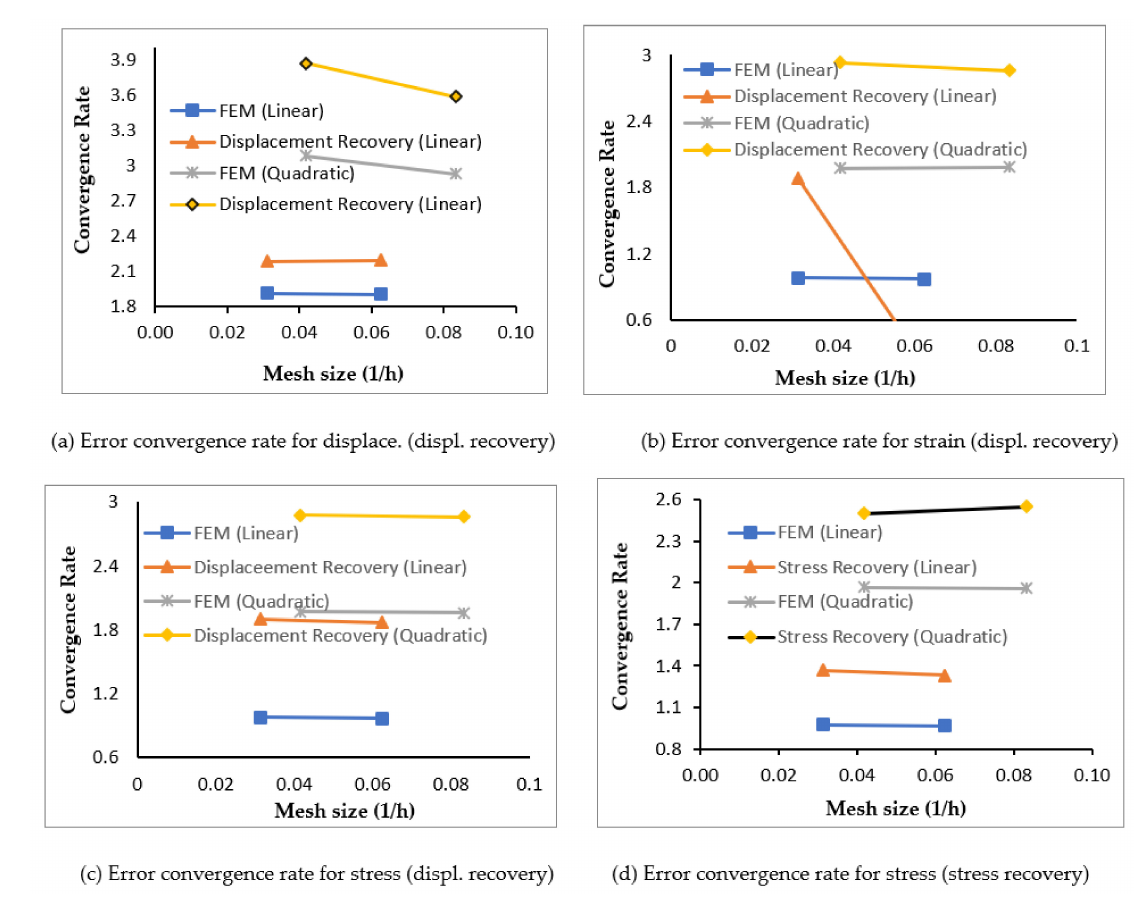
Figure 3. Error convergence rate for different quantity in compressible elastic square plate exam- ple considering displacement and stress recovery techniques, and using linear and quadratic triangular elements. Table 3. Error in displacement, strain and stress (L 2 -Norm), and global effectivity ( θ ) in compressible elastic square plate example considering displacement and stress recovery technique.